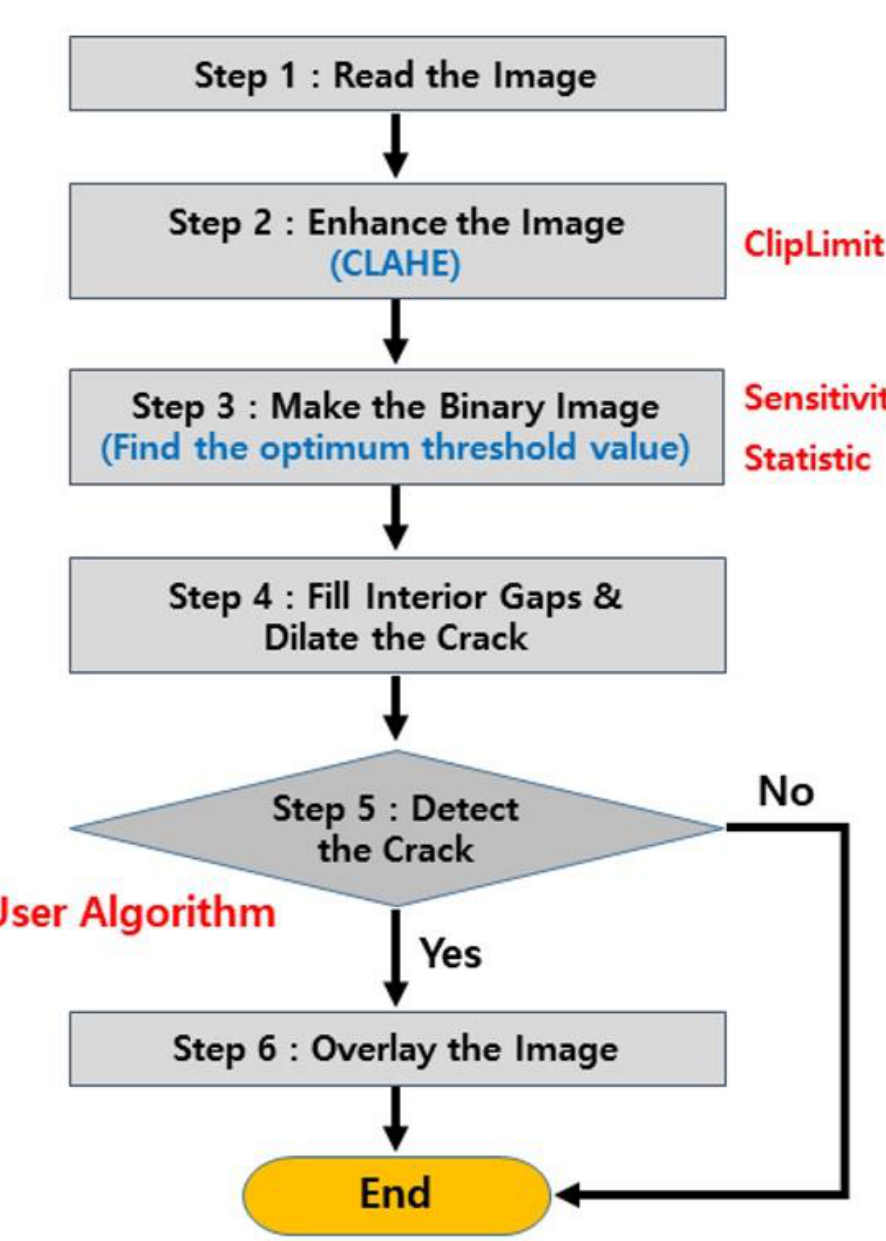
Figure 3. Flowchart of crack detection.